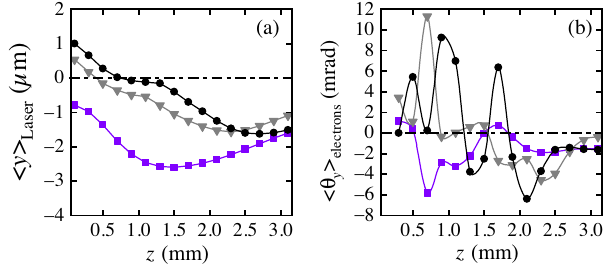
FIG. 8. Simulation results for (a) the evolution of the center of mass of the laser fluence inside a disk of 20 μ m radius, and (b) of the average angle of the electrons accelerated to the energy peak, as a function of position on the laser axis, for three focal positions: − 0 . 8 mm (purple square symbols), 0.4 mm (gray triangles), and 0.7 mm (black (a) and (c) of Fig. 7 and a periplateau focal position corresponding to the simulated case with the lowest electron bunch axial deflection.